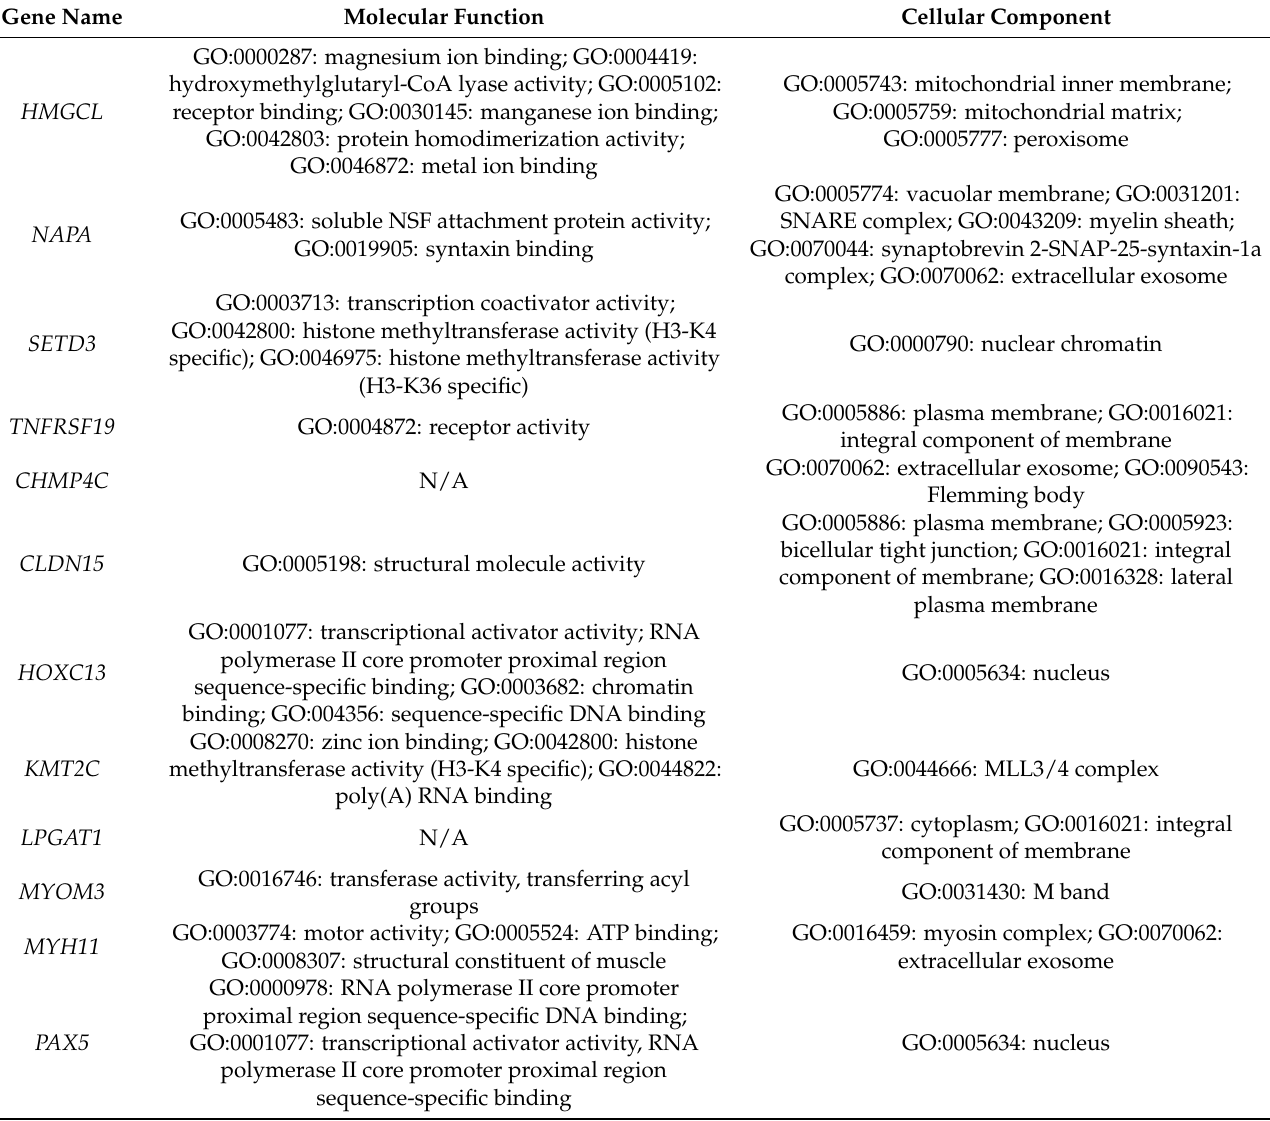
Table 4. Gene Ontology for DMRs identified in CON vs.OVER Females.